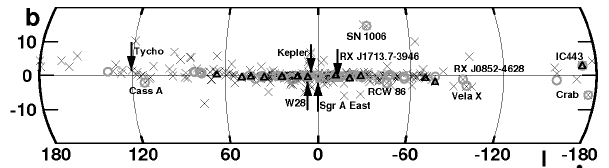
Figure 3: The position of the galactic TeV gamma ray sources (circles) are overlayed on top of the supernova remnants from the Green’s catalog. The triangles show the the Fermi/LAT gamma ray sources from its first catalog (Abdo et al